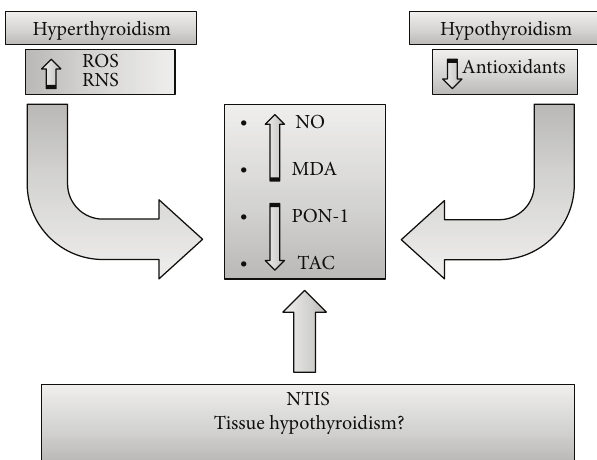
Figure 2: Both hyperthyroidism and hypothyroidism can cause oxidative stress but with different mechanisms. We speculate that nonthyroidal illness syndrome (NTIS) may represent a tissue hypothyroidism condition linked to intracellular and systemic oxidative stress. MDA: malondialdehyde; NO: nitric oxide; PON-1: paraoxonase-1; RNS: reactive nitrogen species; ROS: reactive oxygen species; TAC: total antioxidant